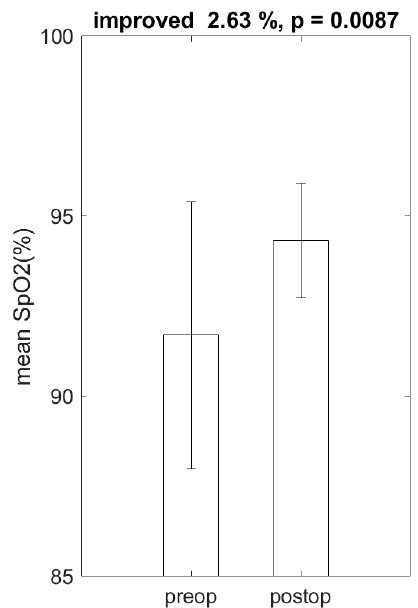
Figure 9. Mean SpO 2 improved 2.63% in “non-surgical success” patients (19/27), p = 0.0087.